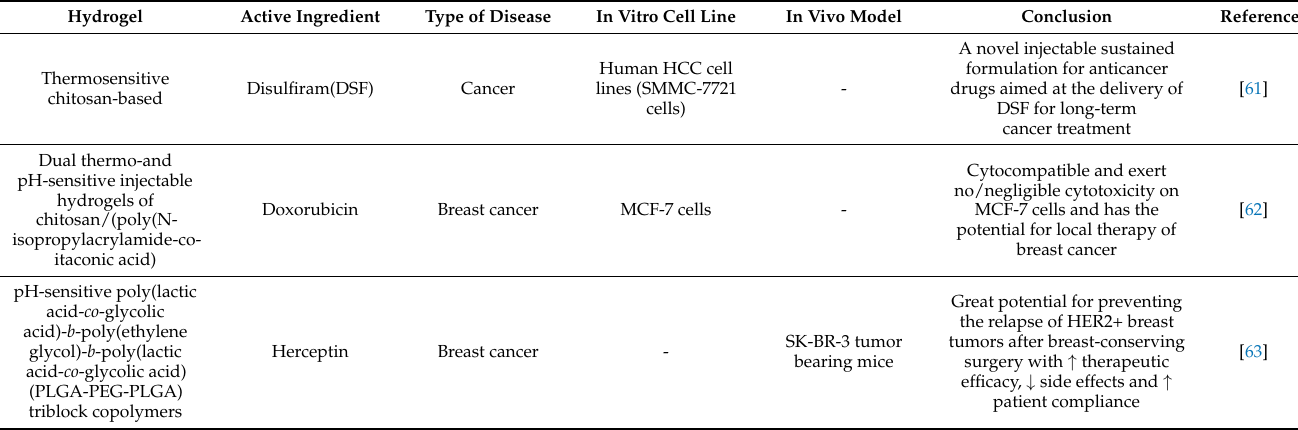
Table 4. List of various injectable hydrogels having biomedical